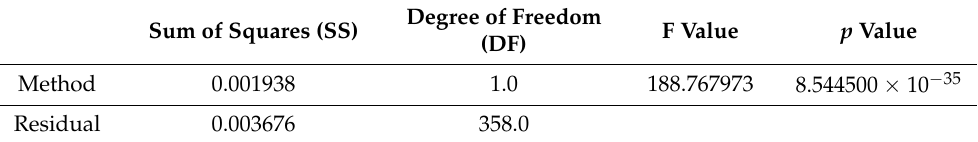
Table 3. ANOVA table results. Sum of Squares